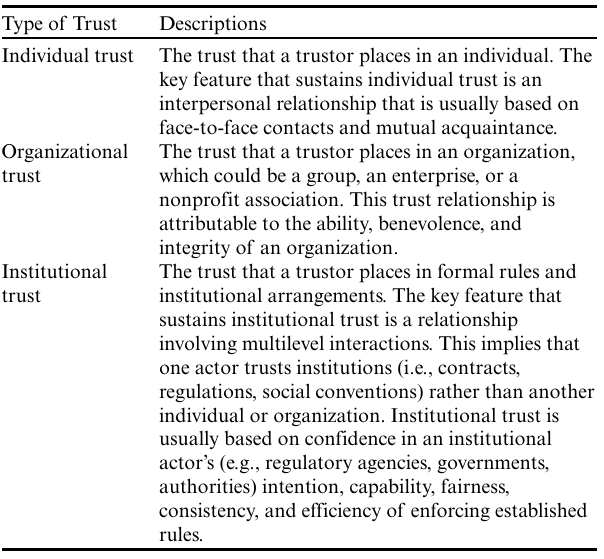
Table 1 . An object-oriented classification of